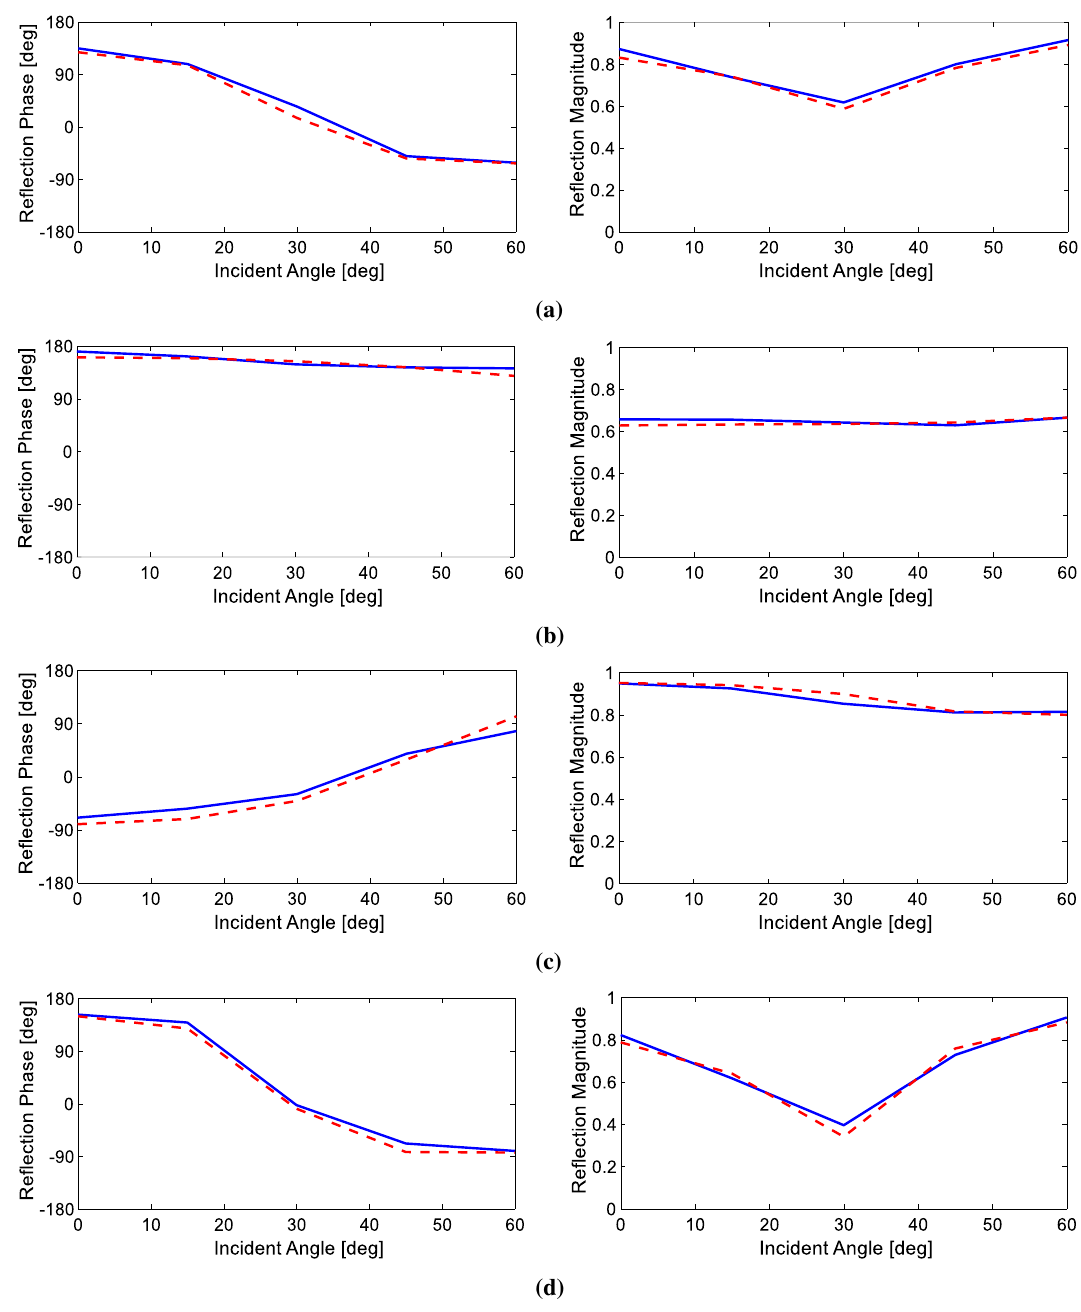
Figure 3. Reflection phases and magnitudes of 4 random validation data with design parameters of ( a ) l 1 = 5.6 mm , l 2 = 4.5 mm , l v1 = -1.5 mm , l v2 = 0.0 mm , ( b ) l 1 = 5.6 mm , l 2 = 0.0 mm , l v1 = -0.3 mm , l v2 = -1.2 mm , ( c ) l 1 = 5.3 mm , l 2 = 2.0 mm , l v1 = -1.2 mm , l v2 = -1.2 mm , and ( d ) l 1 = 5.6 mm , l 2 = 5.0 mm , l v1 = -1.2 mm , l v2 = 1.5 mm , for different incident angles, achieved from numerical simulations (blue diagrams) and the trained neural network (dashed red